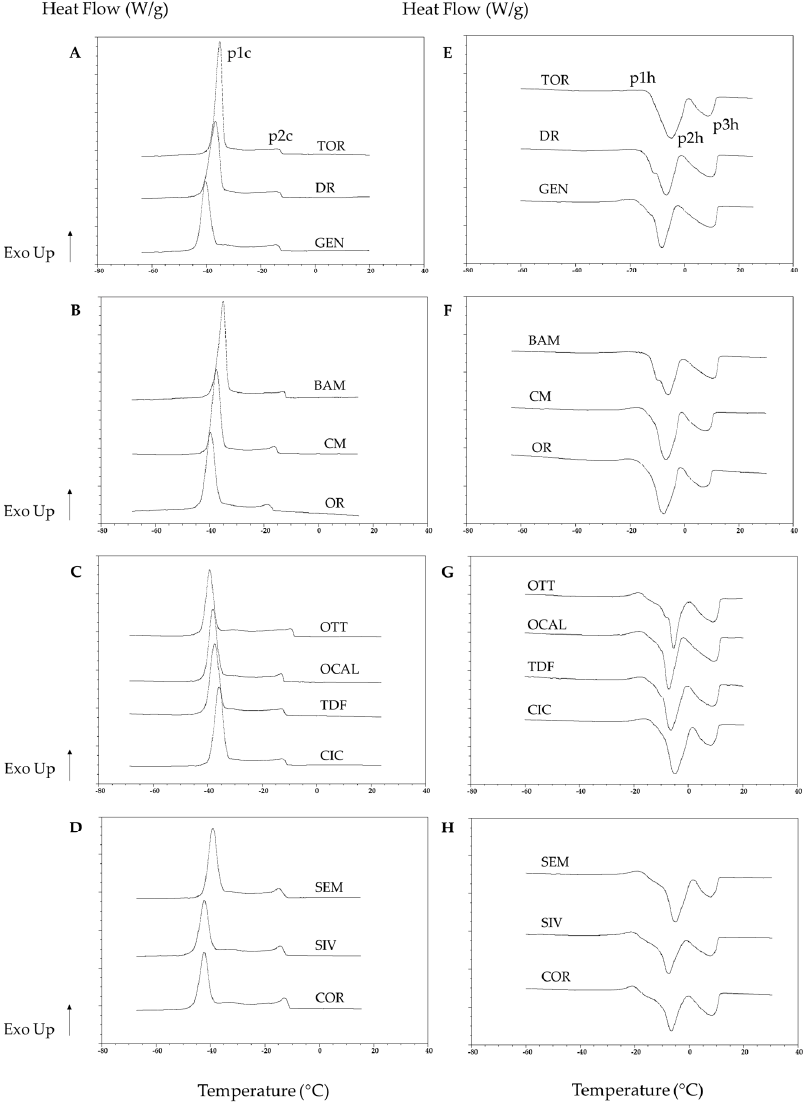
Figure 1. DSC thermograms of the thirteen olive oils (t1) divided by region of origin. A – D : cooling thermograms; E – H : heating thermograms. p1c, p2c: main thermal events on cooling; p1h, p2h, p3h: main thermal events on heating.